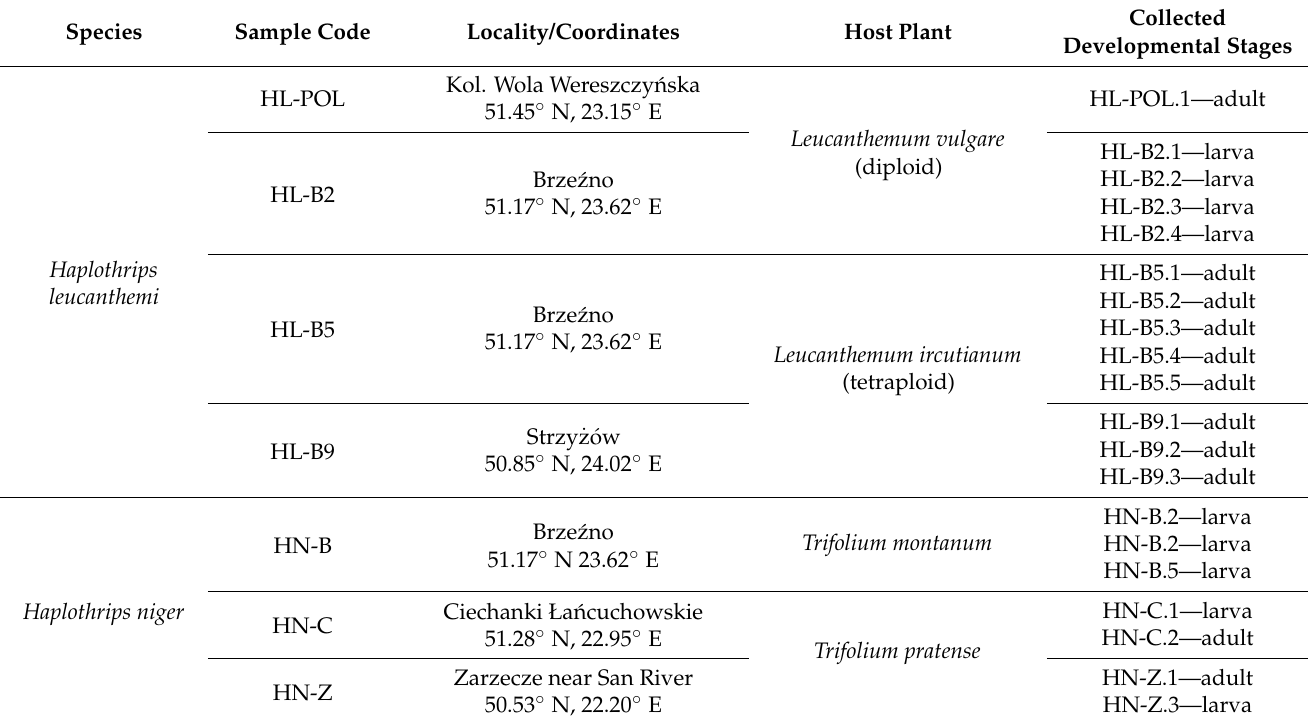
Table 1. Detailed information about specimens of both Haplothrips leucanthemi and H. niger collected from selected sampling sites for further molecular